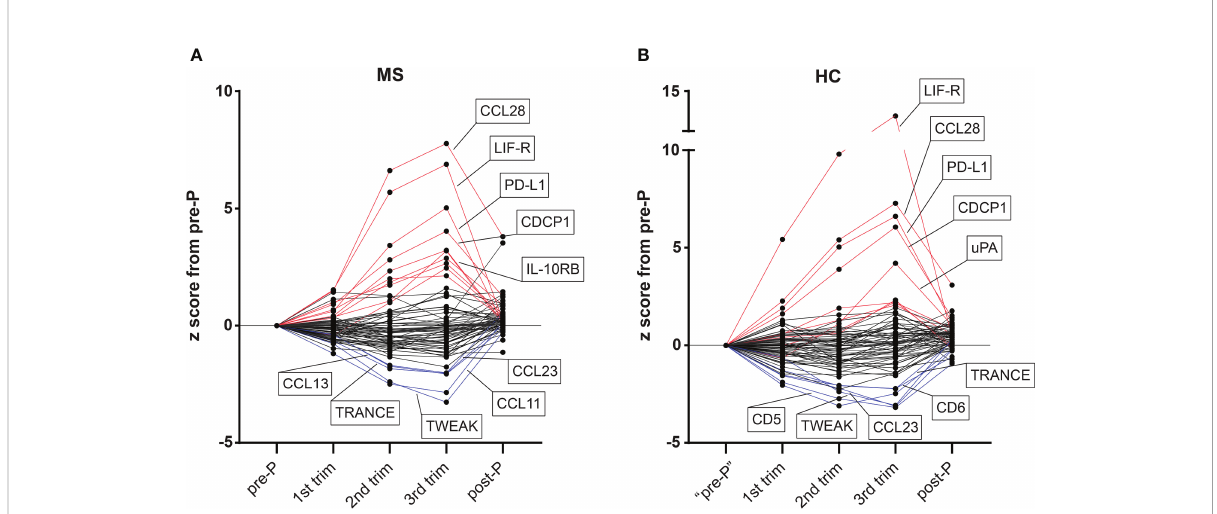
FIGURE 2 Overview of dynamic changes in plasma proteins during pregnancy in MS and HC. (A, B) The levels of all 72 detectable proteins (detected in >50% of samples) measured by the proximity extension assay methodology in plasma samples from MS patients (n=15) and healthy controls (HC, n=10) are presented as z scores from the pre-pregnancy sample (example for 3 rd trimester: (mean 3rd trim – mean pre-P )/std pre-P ). For the pre-pregnancy sample in the HC group, an independent non-pregnant group was included (n = 14, after exclusion of one sample due to failure in quality control). Proteins with ≥ +2 z score in the 3 rd trimester versus pre-pregnancy are colored in red and those with ≥ -2 z score are shown in blue. The top fi ve up and top fi ve downregulated proteins in each group are highlighted in the fi gure. HC, healthy controls; MS, multiple sclerosis; post-P, post- partum; pre-P, pre-pregnancy; trim,